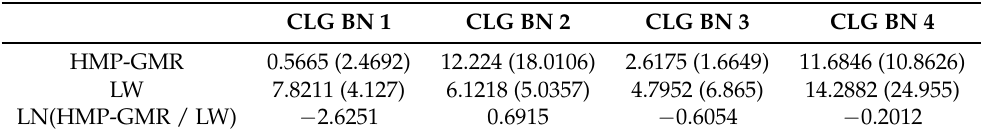
Table 6. Comparison between three algorithms on averages of